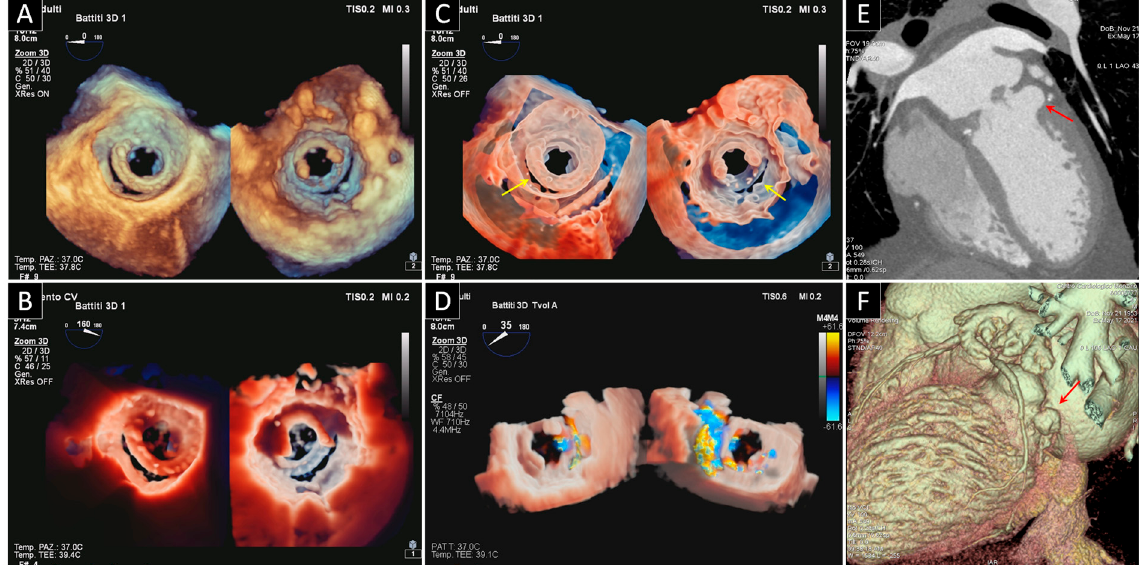
Figure 3. Bioprosthetic mitral valve detachment plus annulus pseudoaneurysm. ( A ) Standard 3D TEE rendering of prosthetic mitral valve from left atrial (surgeon’s view) and ventricular perspective demonstrating detachment from 6 to 9 o’clock due to prosthesis dehiscence. ( B ) Transillumination rendering technique with virtual light source highlighting the localization of the detachment. ( C ) 3D transparency technique more clearly delineating the borders and edges of the paravalvular defect (yellow arrows). ( D ) 3D transparency feature merged with color clearly showing the presence of a severe regurgitation through the area of periprosthetic detachment. ( E ) CT imaging revealing a mitral prosthetic annulus pseudoaneurysm (red arrow) at the ventricular posterolateral wall just under the sewing ring near the detachment of the prosthetic valve in the same patient ( F ) 3D volumetric CT reconstruction of the pseudoaneurysm (red arrow).